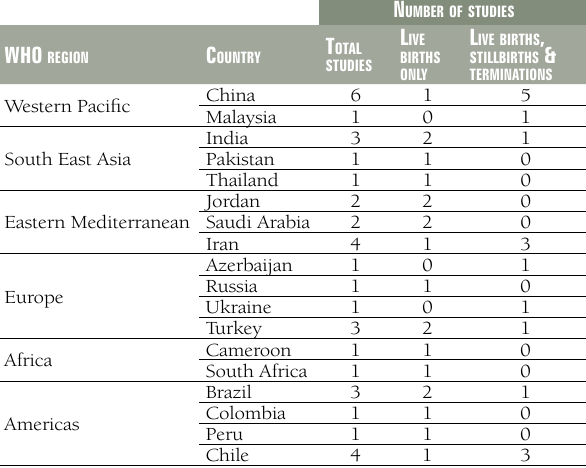
Table 4. Studies that reported rates for total NTD burden